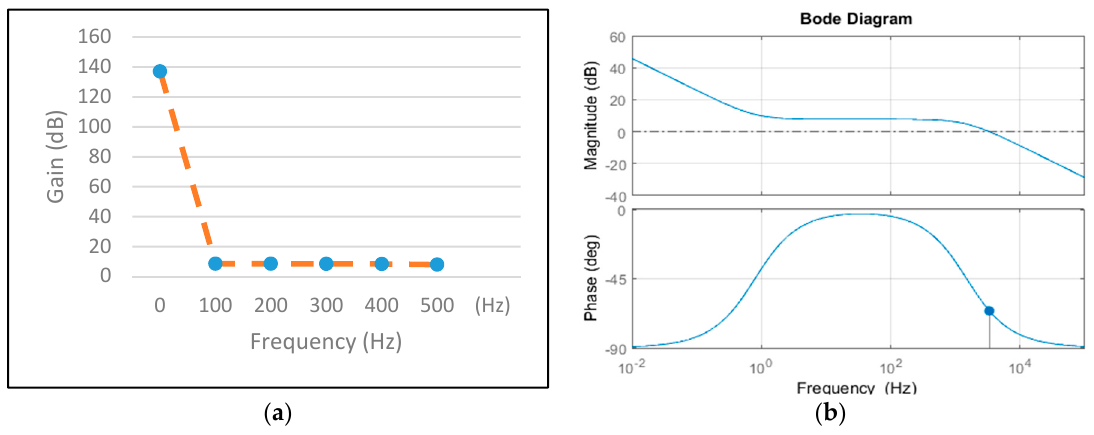
Figure 11. ( a ) Model of the bode plot. ( b ) Bode diagram of the system transformation function.